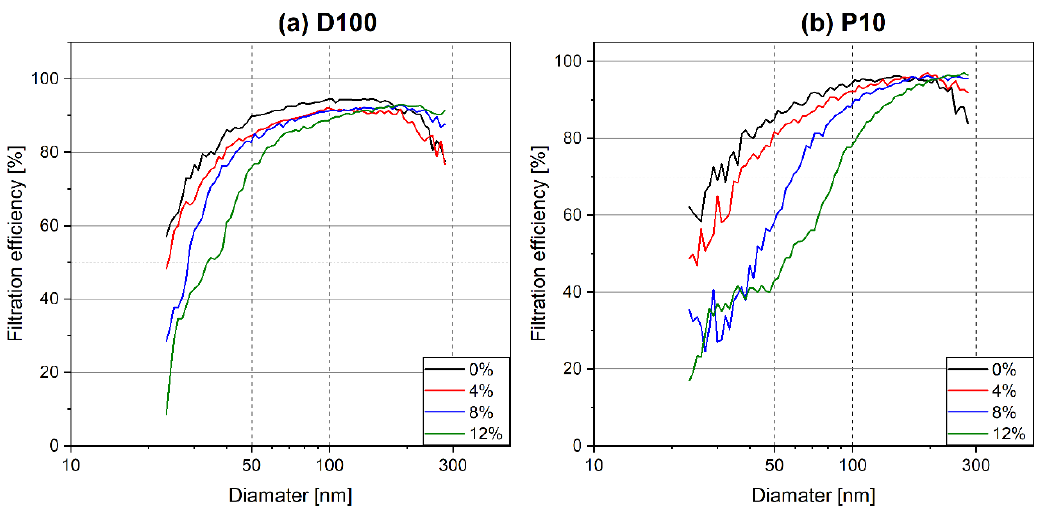
Figure 4. Size-dependent particulate number removal efficiency under various engine loads for ( a ) D100 and ( b ) P10.